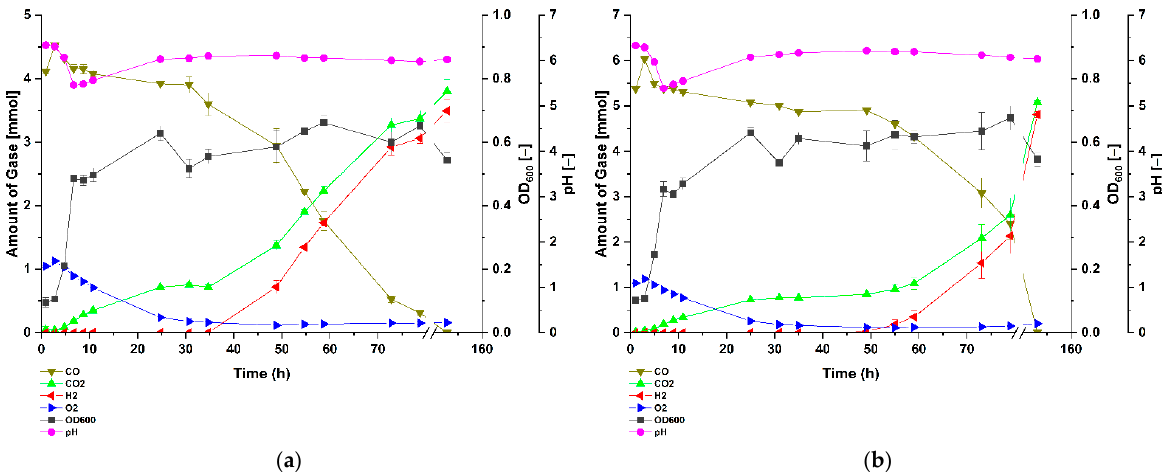
Figure 3. Gas composition and growth of P. thermoglucosidasius DSM 6285 cultivated under ( a ) ~75% and ( b ) ~100% carbon monoxide atmosphere. The strain was grown in stoppered 250 mL serum bottles containing 50 mL of modified ASM medium and an initial O2 concentration of ~1.2 to 1.4 mmol (40 mL at 1 bar pressure). Reported values represent means of triplicate experiments ± standard deviation.